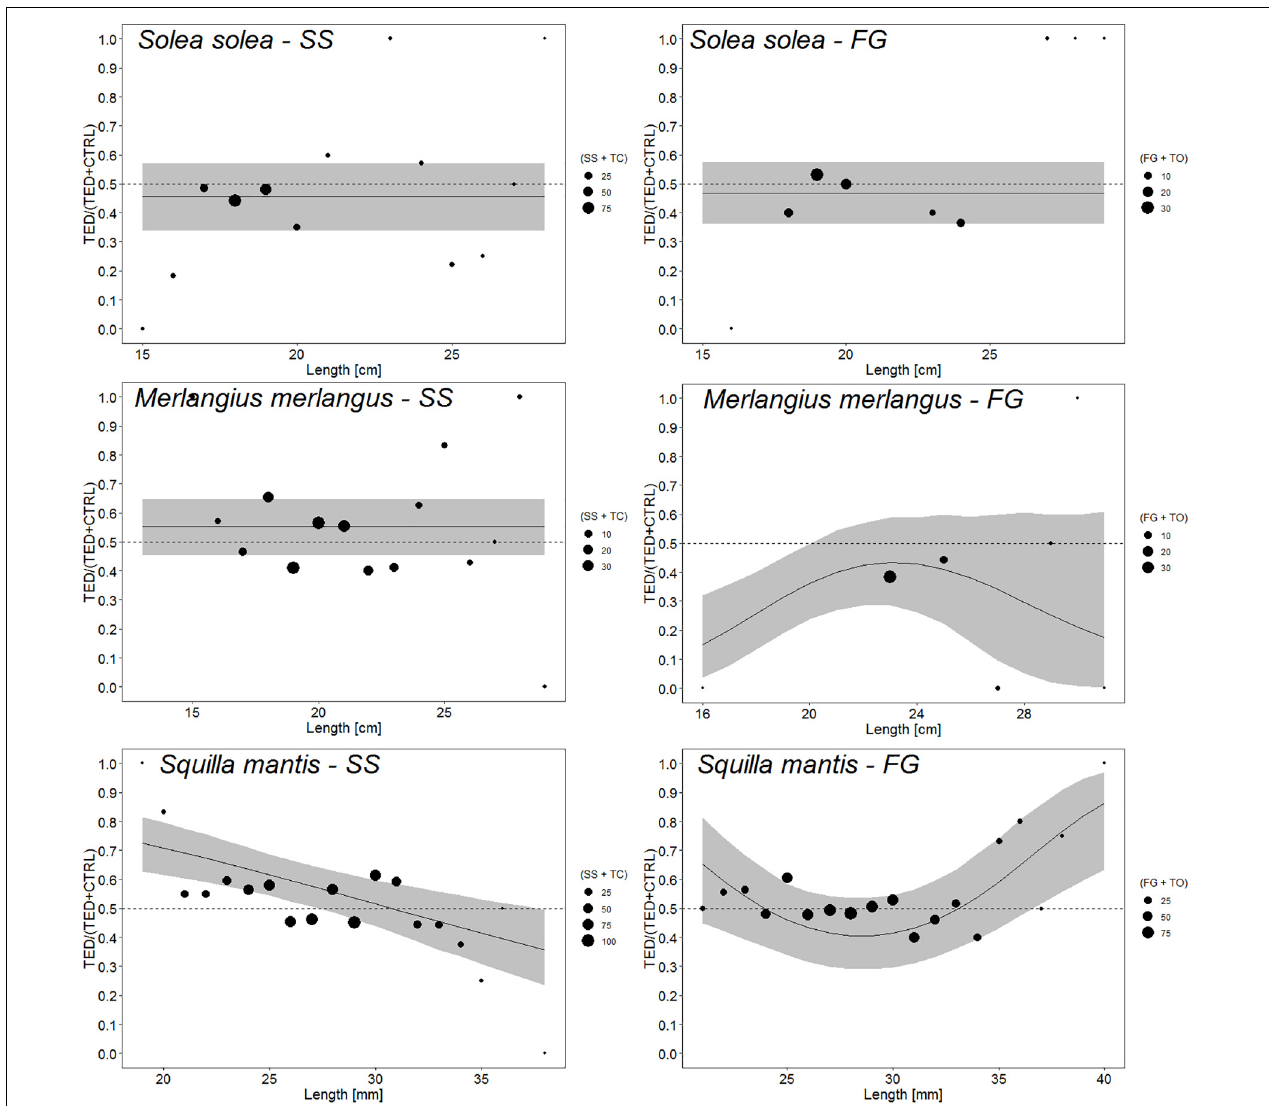
FIGURE 4 | GLMM modeled proportions of the total catches caught by the TEDs. Interpretation: a value of 0.5 indicates an even split between TED and CTRL, whereas a value of 0.25 indicates that the net mounting TED caught 25% of the total fish at that length and 75% were caught in the CTRL net. Shaded area is the 95% confident interval. The size of dots refer to the sum (TED + CTRL) of specimens for each length